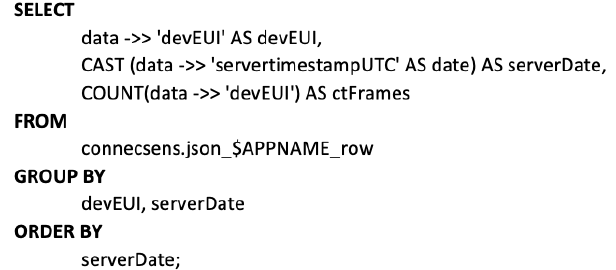
Figure 8. Stored query